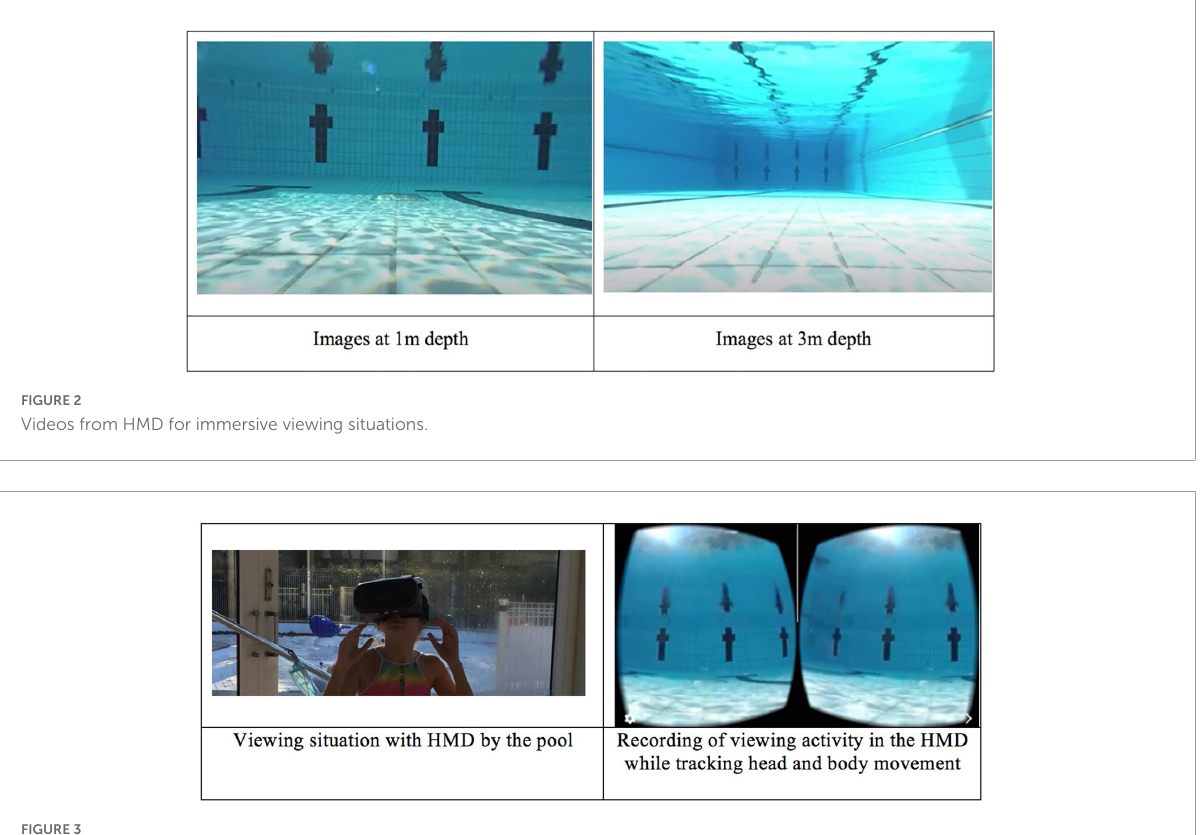
FIGURE3 Method for data collection.